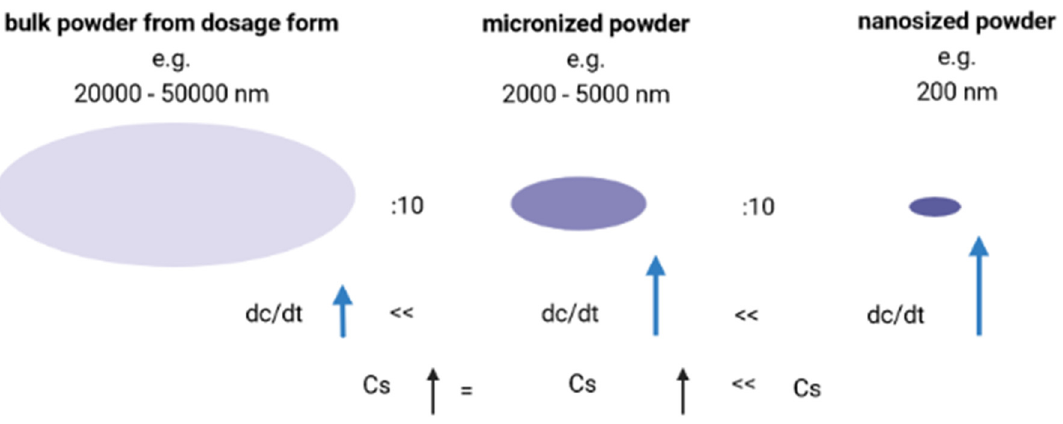
Figure 5. Schematic representation of the variation in the dissolution speed of saturation solubility as a function of particle size [own drawing].